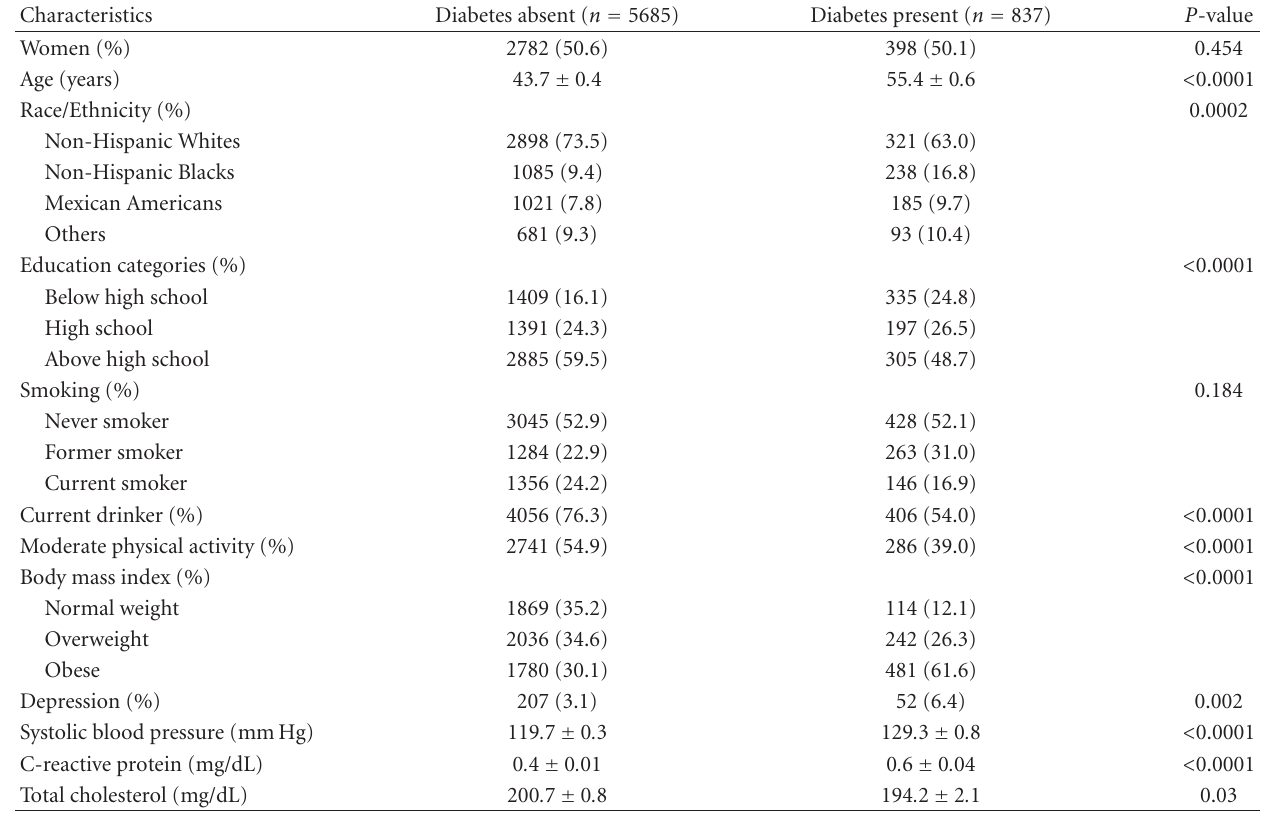
Table 1: Baseline characteristics of the study population ∗